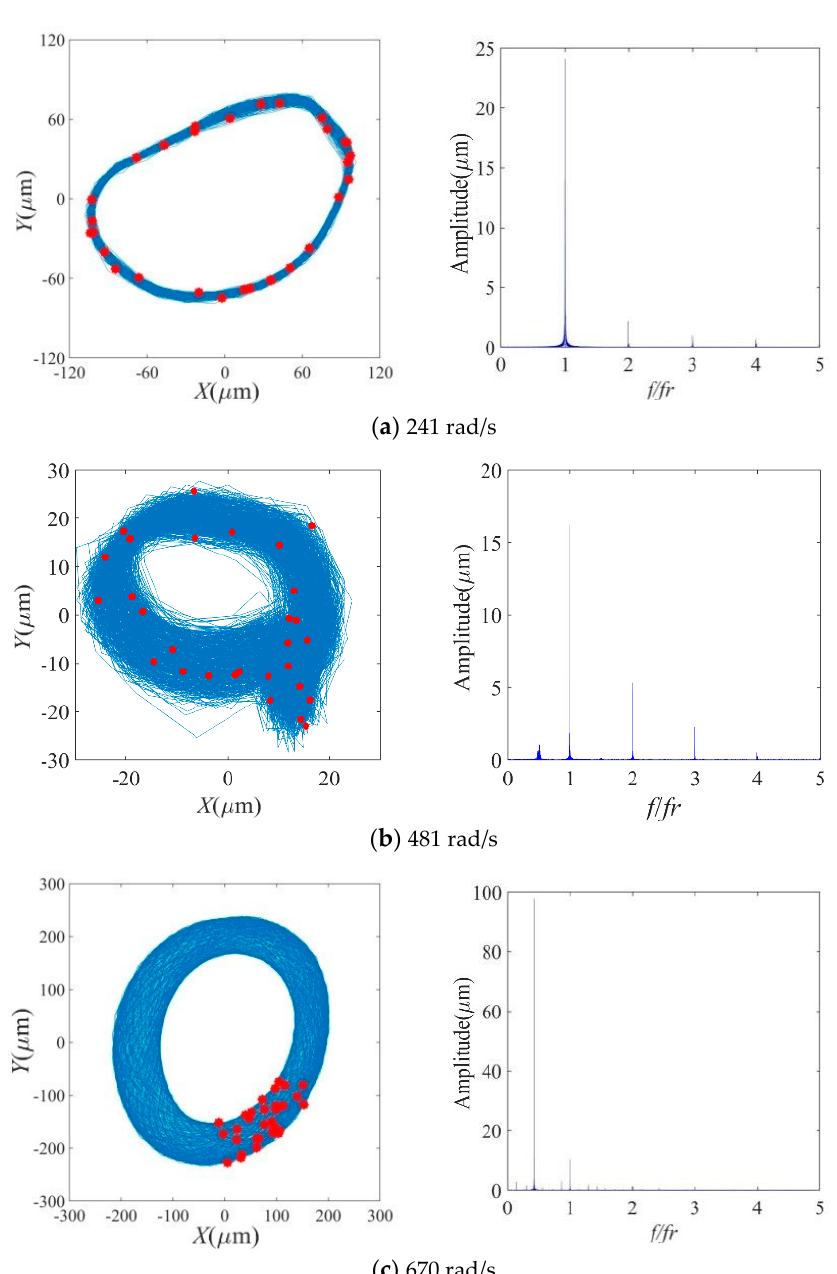
Figure 16. Trajectory of shaft center with the Poincaré map ( left side ) and the power spectrum ( right side ) for the rotating disk at different rotating speeds and oil pressure of 0.75 MPa.